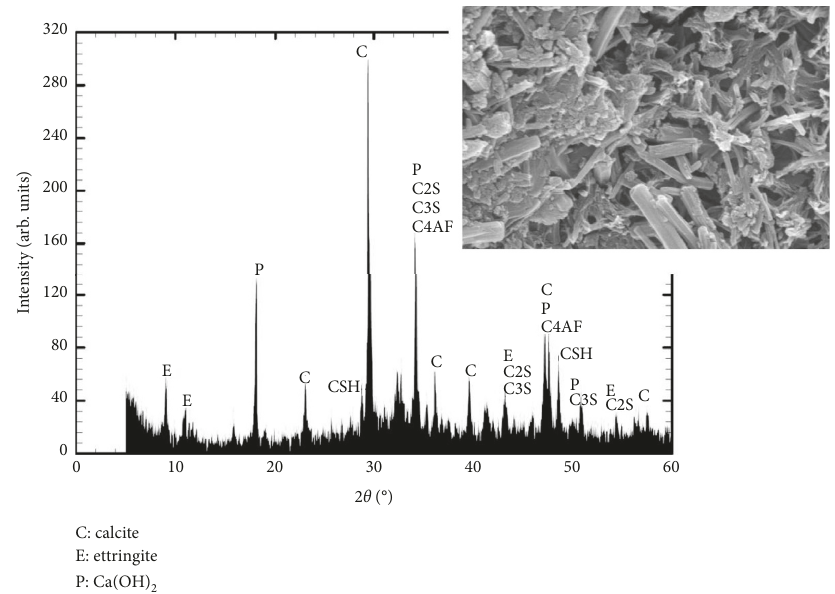
Figure 11: SEM micrographs and XRD patterns of cement-limestone powder paste